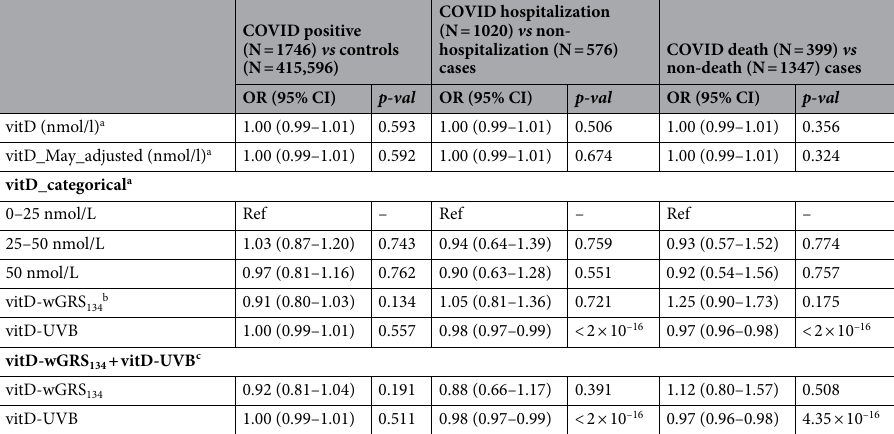
Table 2. Association between Vitamin D and COVID-19 risk in multivariable regression models. a Adjusted for age, gender, body mass index (BMI), month of blood draw (adjusted for vitD and vitD-categorical only), ethnicity, physical activity, smoking and alcohol status, sunshine exposure variables (i.e., time spend outdoors in summer, time spent outdoors in winter and the use of sun/uv protection), vitamin D supplement intake, deprivation index, and comorbidities of CVDs, diabetes, asthma, and malignancy. b Multivariable model was additionally adjusted for the first 20 genetic principal components and genotype panel. c Multivariable regression was fitted by including both vitD-wGRS 134 and vitD-UVB in the same model to examine the effects of genetically predicted vitamin D levels and ambient UVB